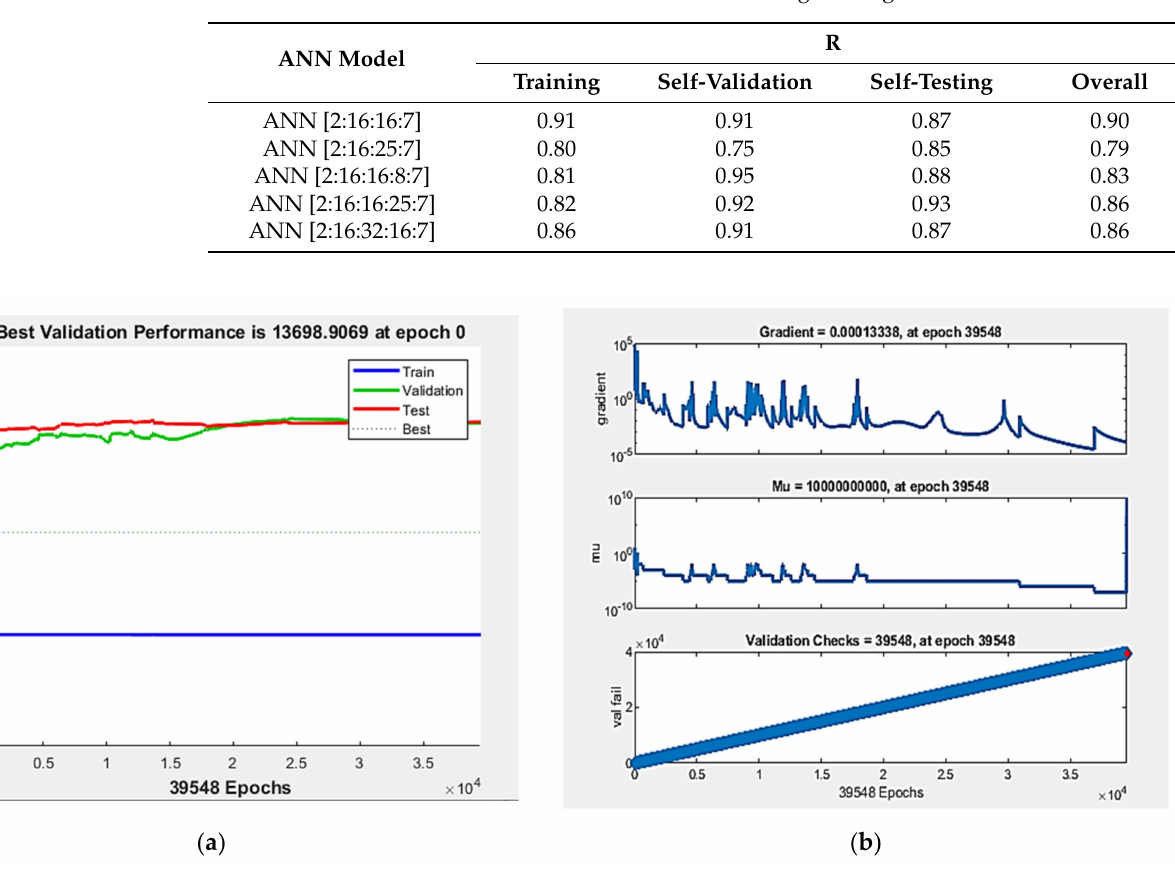
Table 3. Correlation coefficient of best ANN-I models during training.